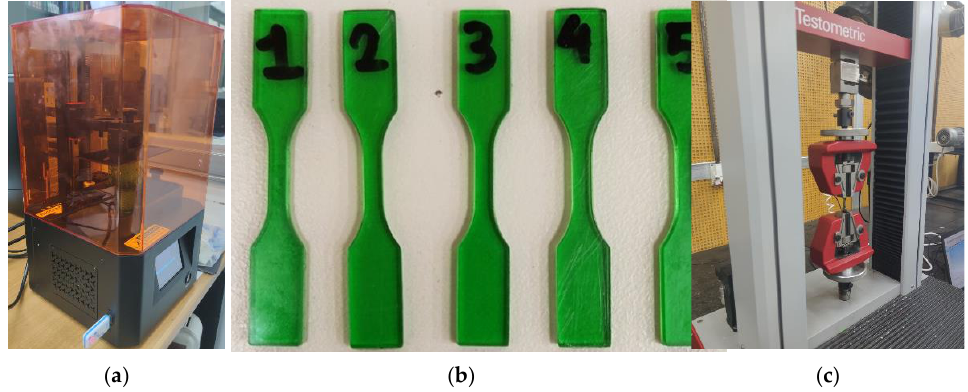
Figure 3. Experimental equipment for investigating the mechanical properties of the raw material: ( a ) utilized 3D printer, ( b ) 3D-printed specimens, and ( c ) their testing in the utilized tensile machine. Table 1. Information regarding the present 3D printer and printing process profile. ASTM Standardized 3D Creality LD-002H UV Resin 3D Printer